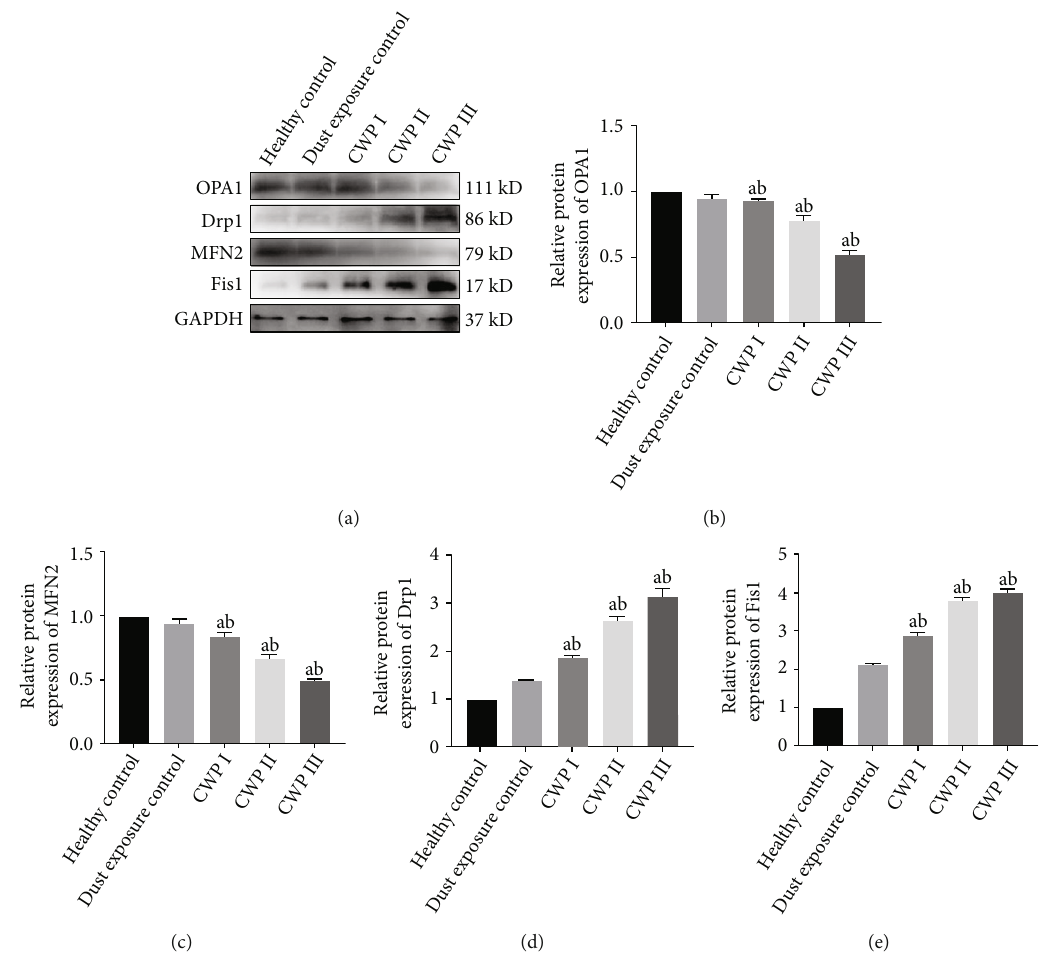
Figure 5: Relative protein expression levels of fi ssion- and fusion-related genes in serum of coal mine workers. (a) Expression of mitochondrial fi ssion- and fusion-related genes and proteins in serum by western blot analysis. (b) The relative protein expression level of OPA1. (c) The relative protein expression level of Drp1. (d) The relative protein expression levels of MFN2. (e) The relative protein expression level of Fis1. a P < 0 : 05 , compared with the healthy control group. b P < 0 : 05 , compared with the dust exposure control